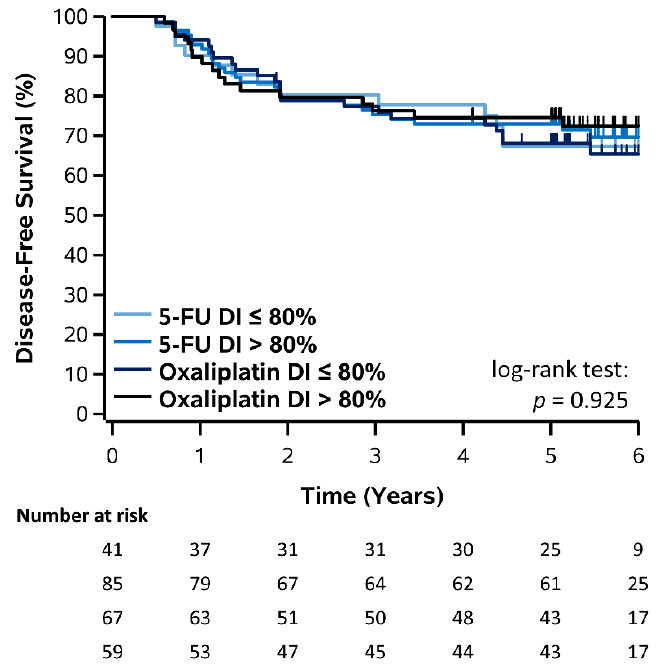
Figure 3. Kaplan–Meier plot of DFS stratified by DI of 5-FU and oxaliplatin in patients receiving FOLFOX.